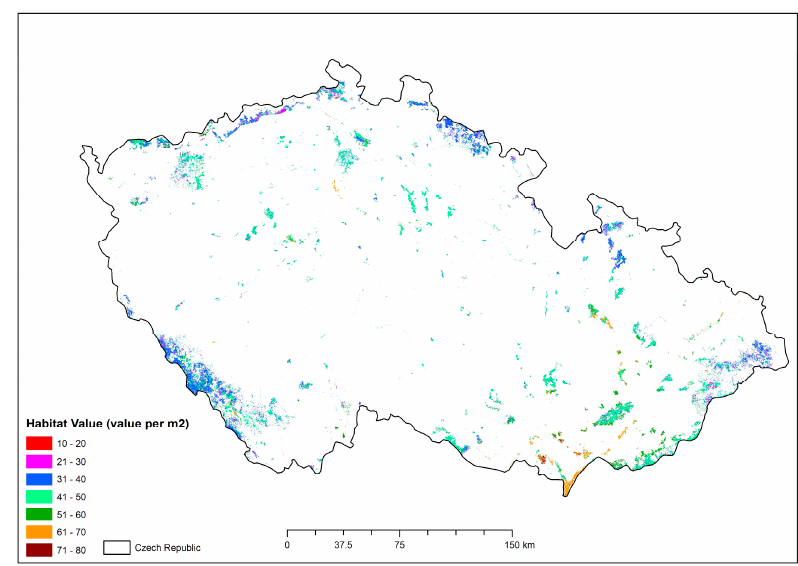
Figure 2. Visualisation of the point value evaluation of natural forest habitats in the Czech Republic.